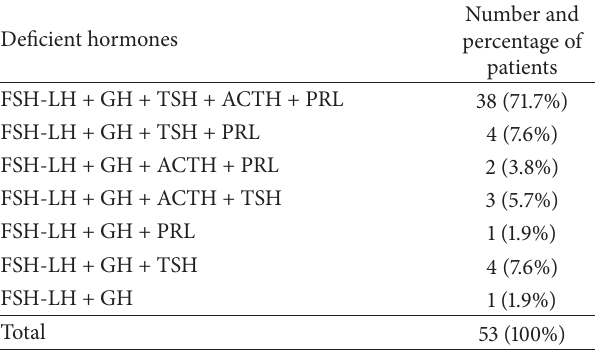
Table 1: Distribution of deficient hormones in patients with SS. Deficient hormones